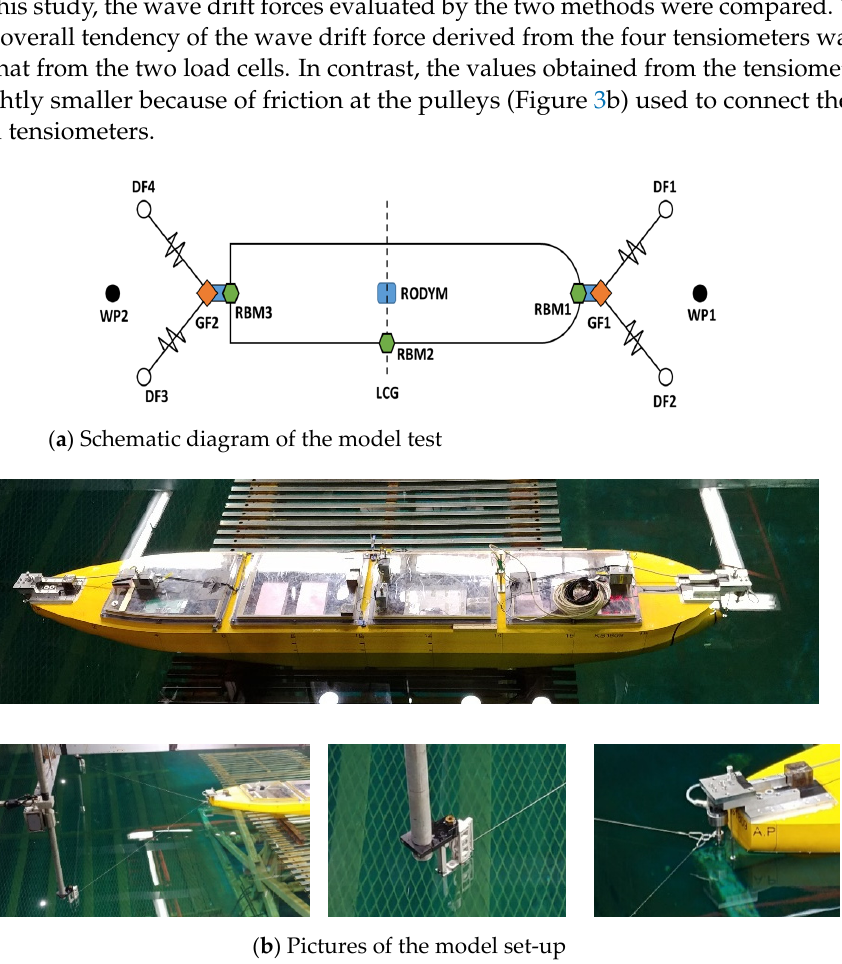
Table 3. Measuring items of model test.